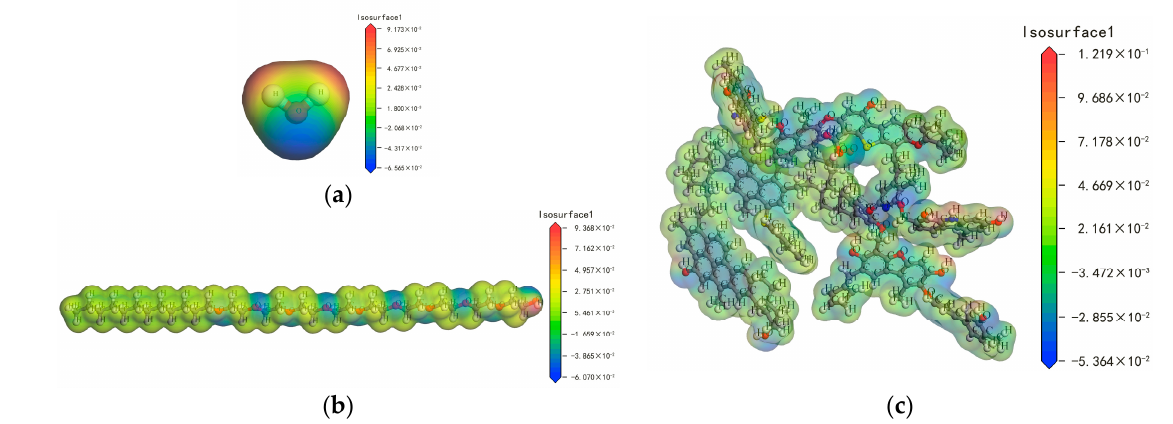
Figure 14. The electrostatic potential of different molecules: ( a ) H 2 O; ( b ) AEO-9; ( c ) bituminous coal. Table 3. The molecular electrostatic potential values of H2O, AEO-9, and bituminous coal.